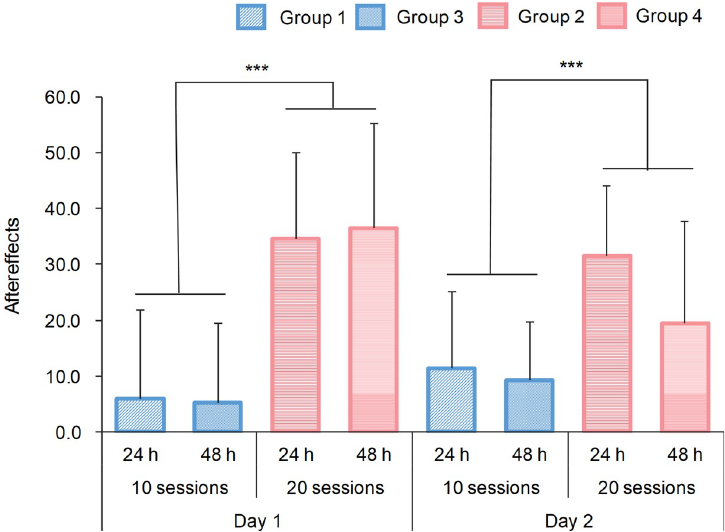
Fig 5. Aftereffects on Day 1 and Day 2. The vertical axis represents the difference between the last rotation session and the first non-rotation session (baseline). A mixed-design ANOVA revealed a statistically significant interaction between the day of training and the amount of training ( F (1,36) = 8.14, p < 0.001, η p 2 = 0.18) and the main effects of 2 = 0.47). A post-hoc test revealed the simple main the amount of training on Day 1 ( F (1,36) = 31.85, p < 0.001, η p effect of the amount of training on Day 1 and Day 2 ( F (1,36) = 34.52, p < 0.001, η p 2 = 0.49; F (1,36) = 11.78, p < 0.01, η p 2 = 0.25) and that of the day of practice in the 20-session groups ( F (1,18) = 6.87, p < 0.05; η p 2 = 0.28). The aftereffects marked with asterisks were significantly higher in the 20-session practice groups than in the 10-session practice groups (all p s < .001).